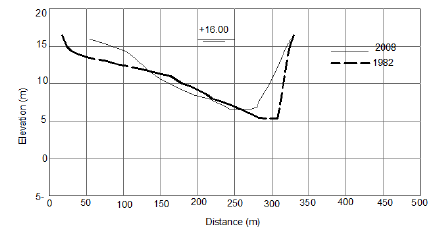
Figure 12. Cross section No.3